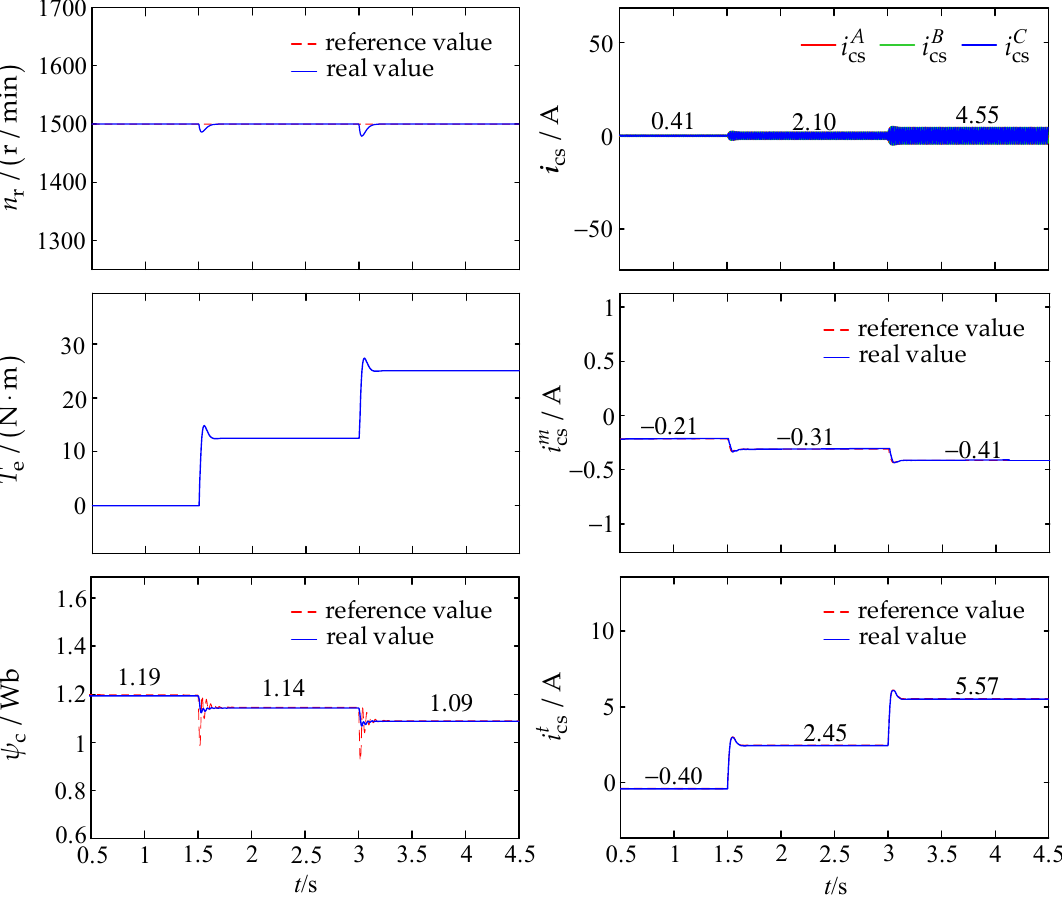
Figure 15. Simulation results of MTPA control when torque changes.